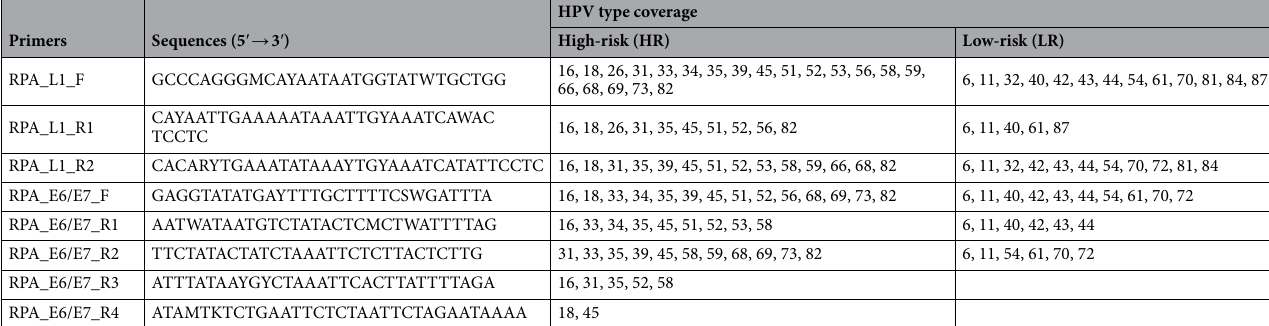
Table 1. RPA primers and their HPV type coverage.